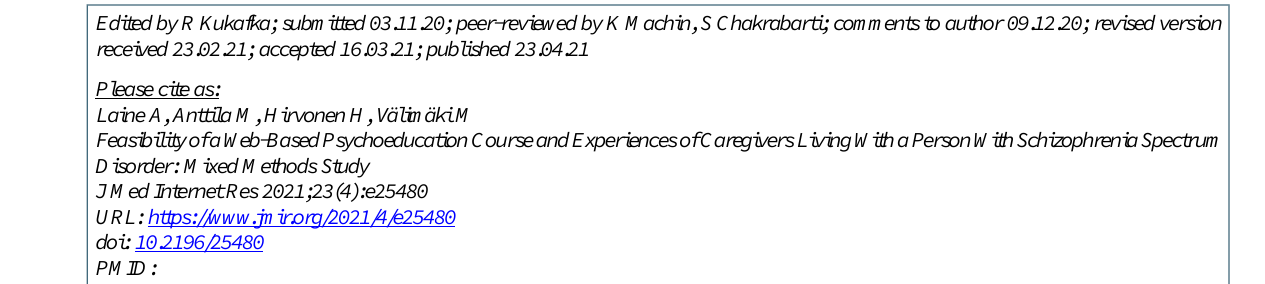
FinFami: Finnish Central Association of Families With People With Mental Illness ICD-10: 10th version of International Classification of Disorders SSD: schizophrenia spectrum disorder